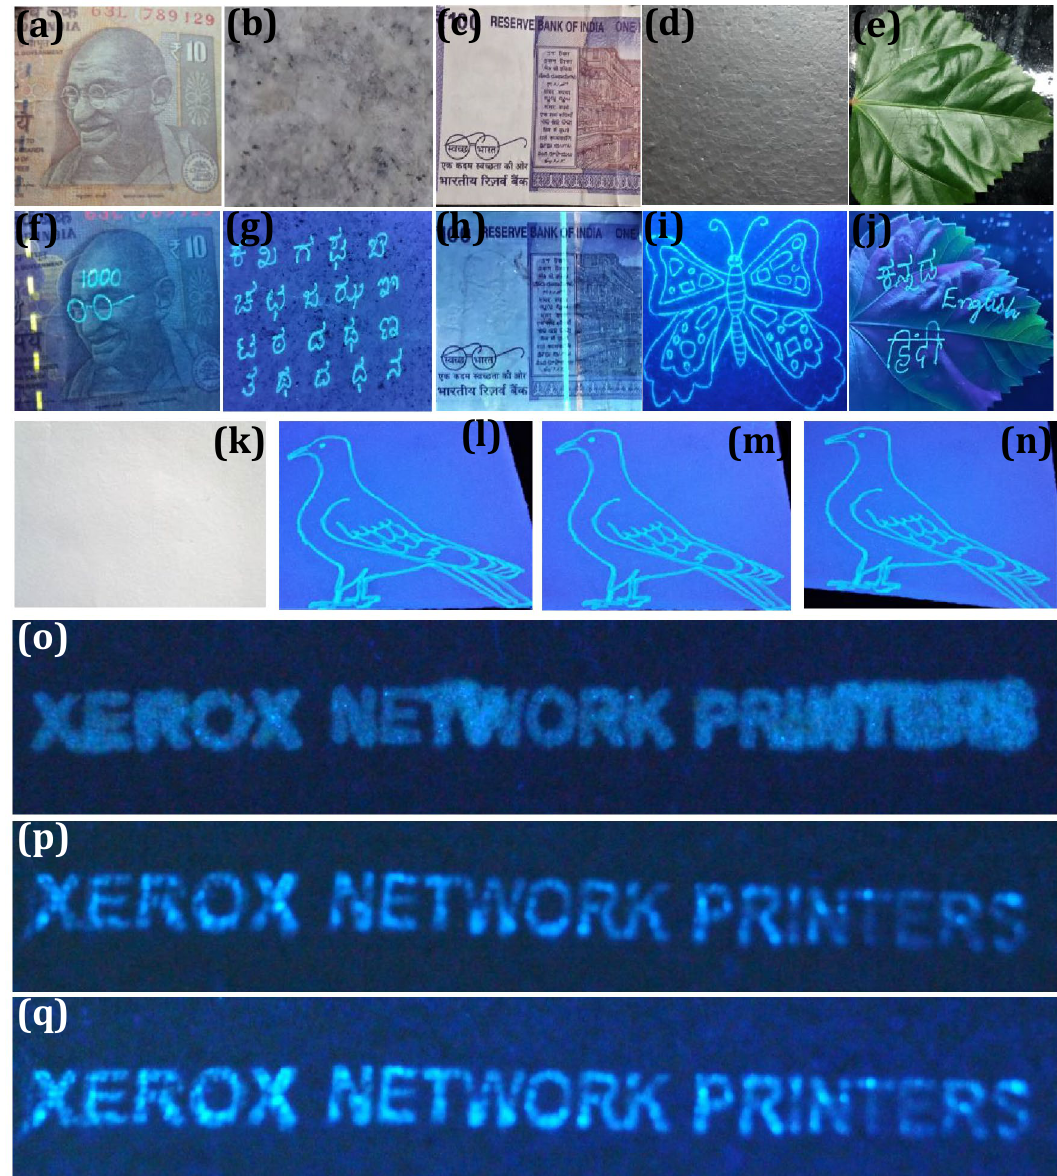
Figure 11. Images of encoded information on various surfaces under ( a–e ) normal light, ( f–j ) UV 365 nm light excitation; ( k–n ) Photographic images of encoded handwritten information on the glassy ceramic tile surface and treated with various time period and temperature (30 days at RT, below 90 °C for 24 h, 100 °C for 30 min); fluorescent images of decoded patterns under UV 365 nm light excitation showing high reliability on the paper surface by treated with ( o ) water, ( p ) oil and ( q ) acetone for ~ 12